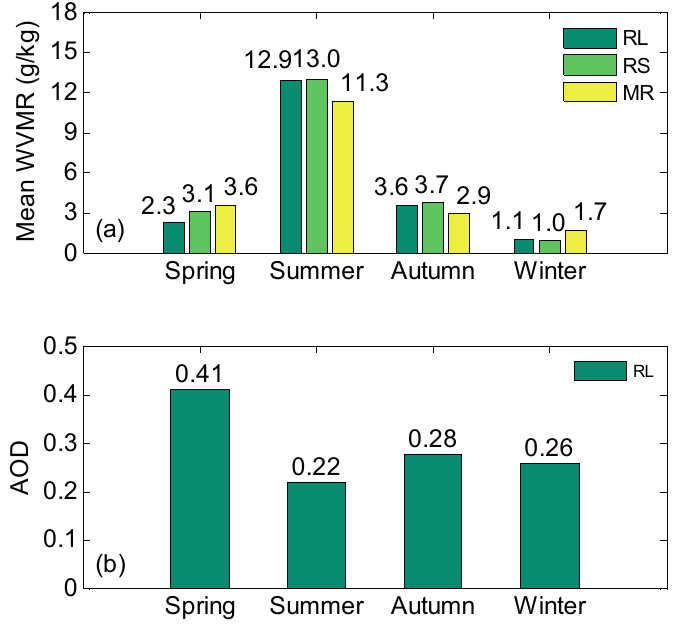
Figure 7. Quarterly mean WVMR from 0.5 km to 3 km measured by RL, RS, and MR, respectively. Quarterly mean AOD from 0.5 km to 3 km retrieved by